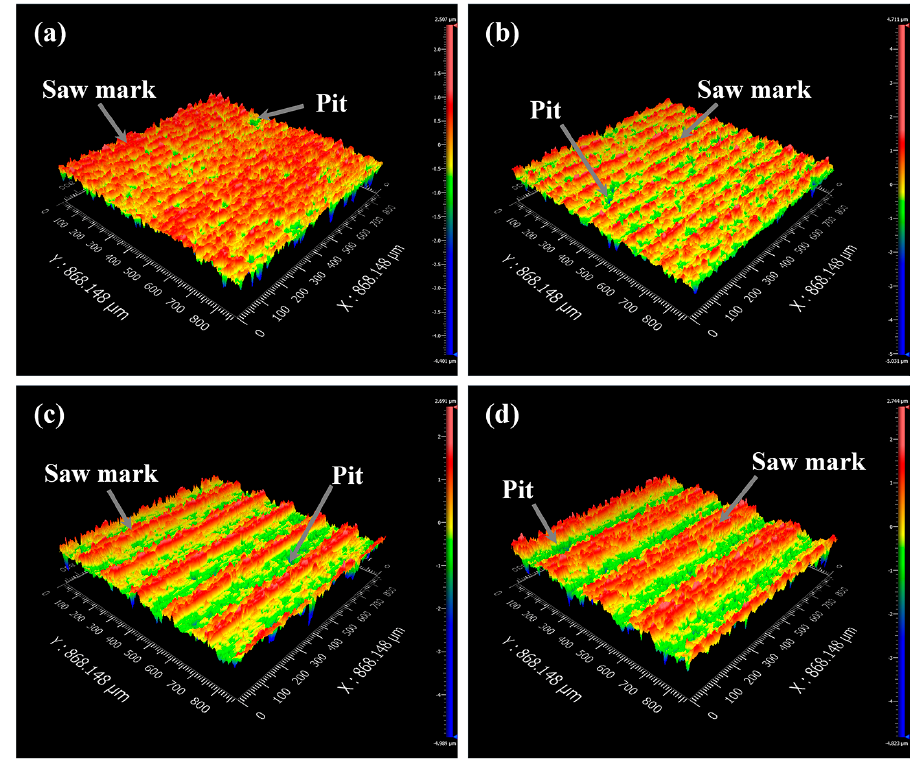
Figure 8. Surface morphology of the sawed surface at P = 0.18 MPa, v s = 1.8 m/s with a feed speed of: ( a ) v f = 0.05 mm/min; ( b ) v f = 0.1 mm/min; ( c ) v f = 0.2 mm/min; and ( d ) v f = 0.3 mm/min.